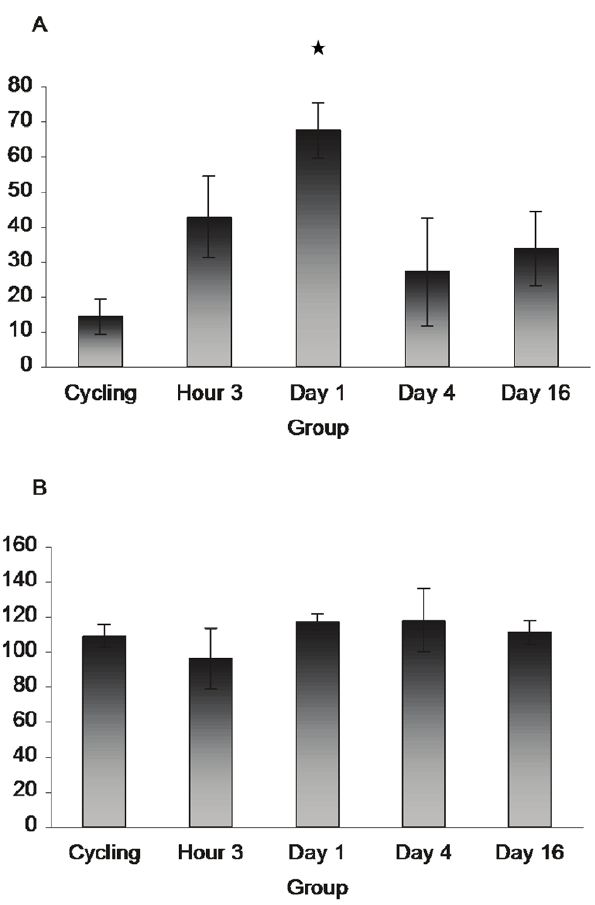
Figure 5. Reproductive state changes Glutamine Synthetase-ir within Cg2. Panel A shows results from the Cg2 and panel B the MPOA. Asterisks denote a significant difference (p , .05) from all other groups. (n=4 for all